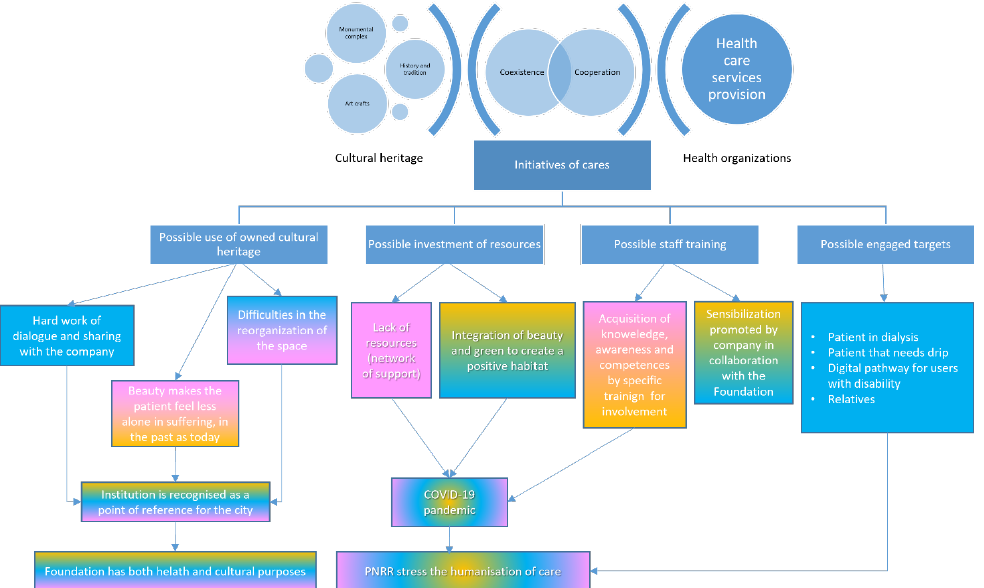
Figure 1. Coding process illustrating the results of the Santa Maria Nuova hospital case (general management in yellow, cultural heritage management in blue, health management in pink).